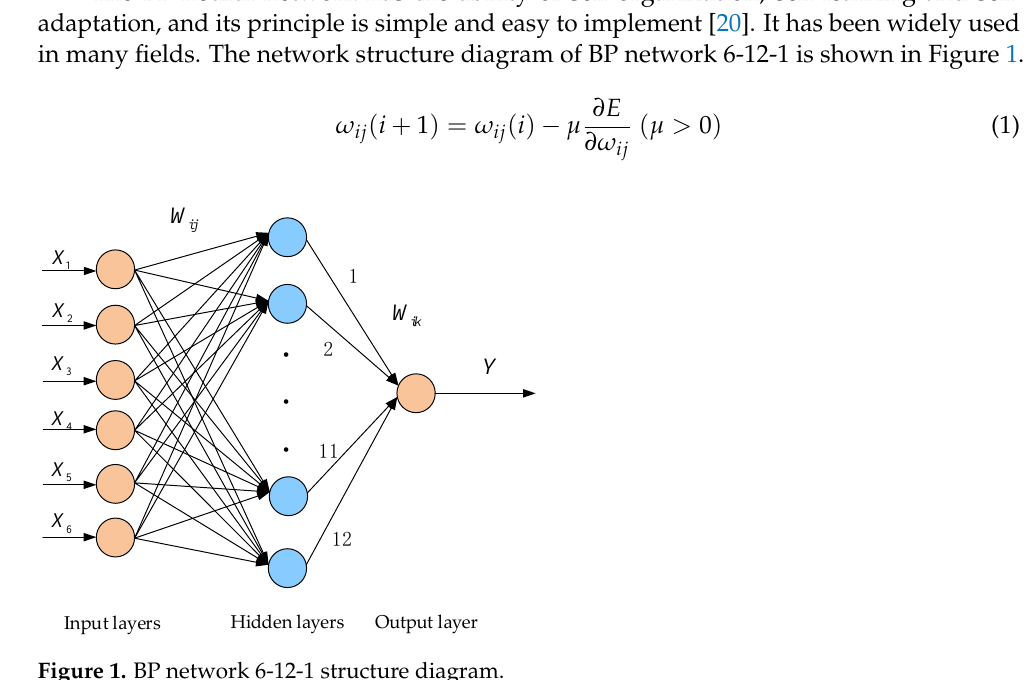
Figure 1. BP network 6-12-1 structure diagram.